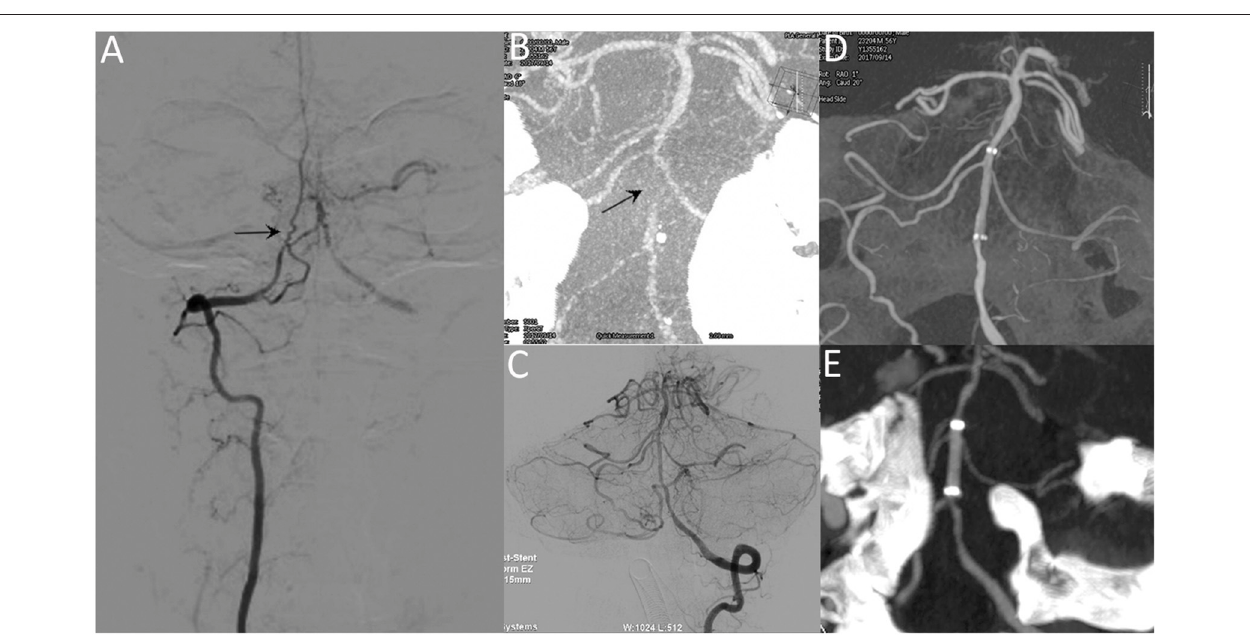
FIGURE 1 | A 65-year-old female with a significant symptomatic stenosis of the right MCA. Preprocedural DSA images demonstrate high-grade stenosis (arrow) (A) and the tortuous right ICA (arrow) (B) . Postprocedural DSA images (C) reveal a residual stenosis of 10% (Insert: radiopaque markers of the stent). Unsubtracted angiogram (D) and XperCT (E) reveal patent stent with good apposition at the 8-month follow-up.